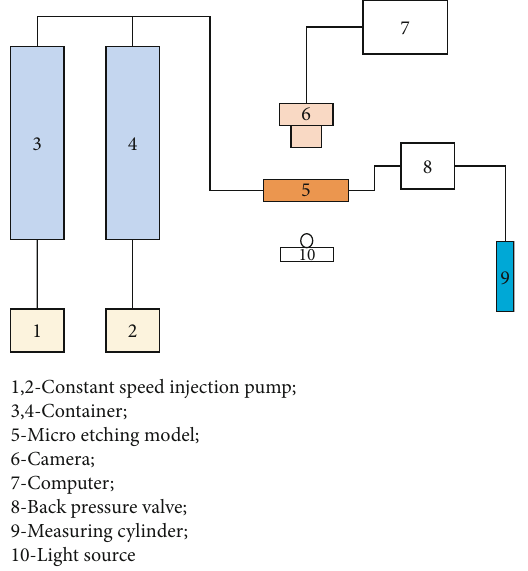
Figure 2: Microscopic visualization experiment fl